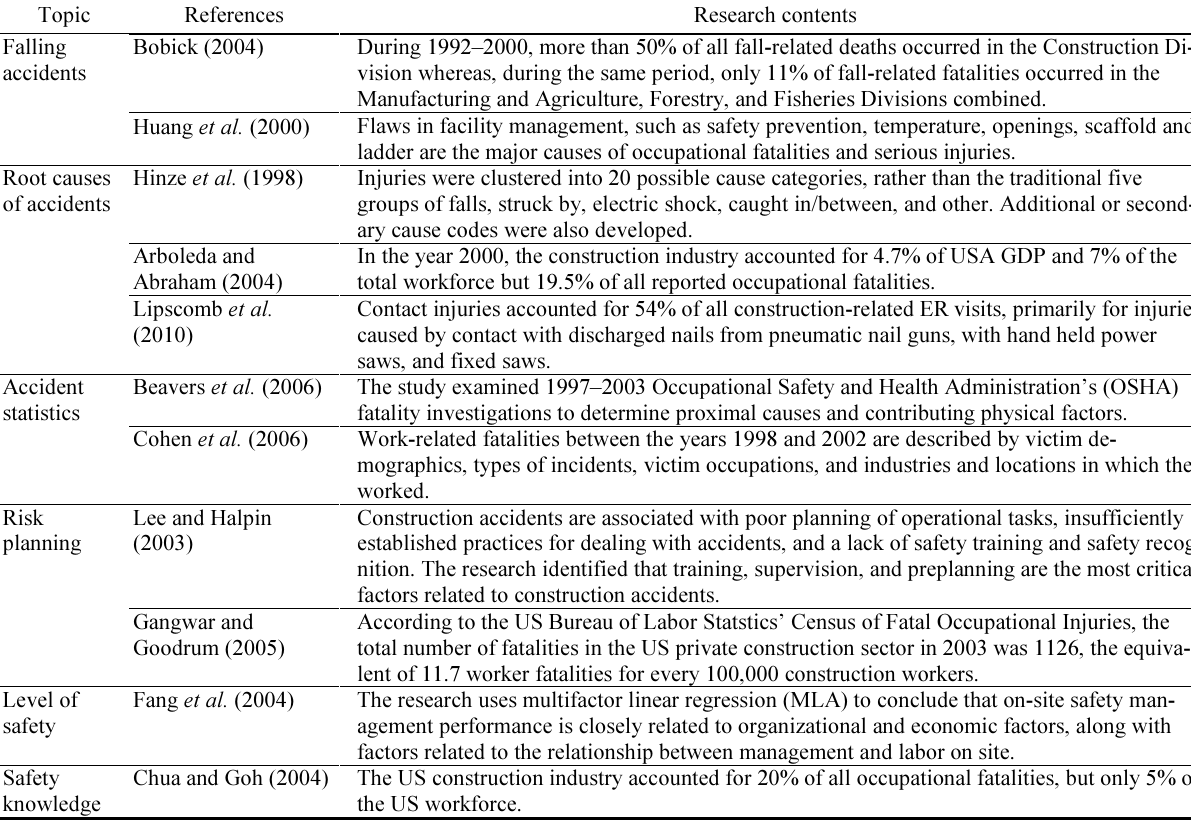
Table 2. Construction industry accident